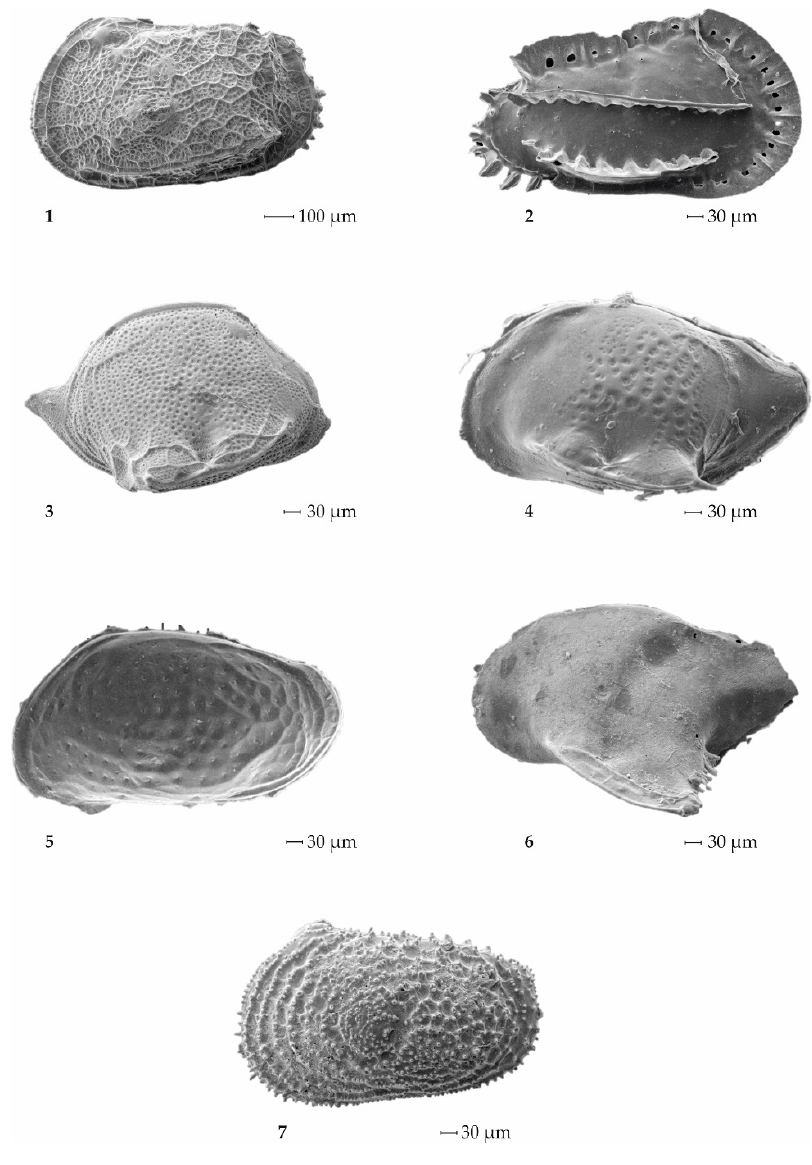
Figure A1. 1— Australicythere polylyca . Lateral exterior view, left valve; 2— Cativella bensoni . Lateral exterior view, right valve; 3— Cytheropteron abyssorum . Lateral exterior view, right valve; 4— Cytheropteron antarcticum . Lateral exterior view, left valve; 5— Cytheropteron ( Loxoreticulatum ) fallax . Lateral exterior view, left valve; 6— Cytheropteron sp. Lateral exterior view, left valve; 7— Echinocythereis sp. Lateral exterior view, left valve.